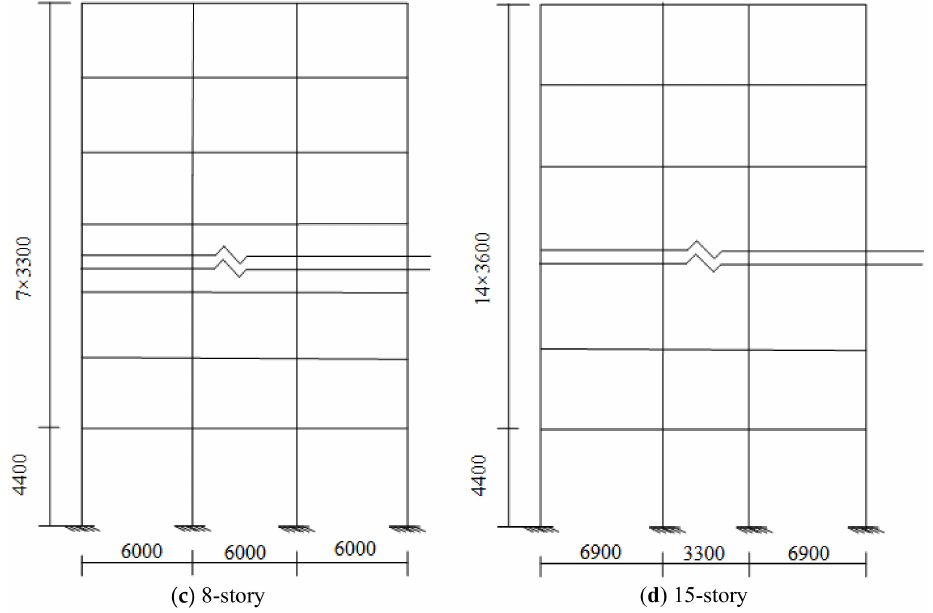
Figure 6. Elevation of four representative reinforced concrete frame structures (unit: mm). Table 3. Beam section properties of four RC frame buildings.